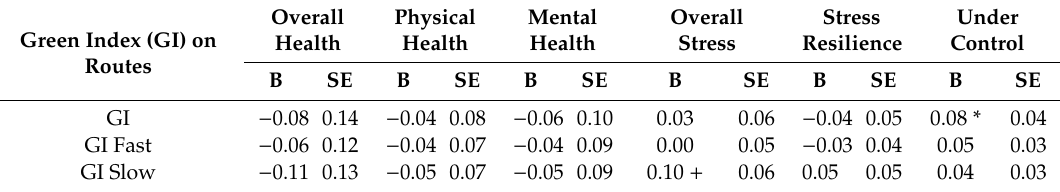
Table 6. Relationship between Weighted Green Index along Daily Routes and Health Outcomes. Overall Physical Mental Overall Stress Under Green Index (GI) on Health Health Health Stress Resilience Control Routes B SE B SE B SE B SE B SE B SE GI − 0.08 0.14 − 0.04 0.08 − 0.06 0.10 0.03 0.06 − 0.04 0.05 0.08 * 0.04 GI Fast − 0.06 0.12 − 0.04 0.07 − 0.04 0.09 0.00 0.05 − 0.03 0.04 0.05 0.03 GI Slow − 0.11 0.13 − 0.05 0.07 − 0.05 0.09 0.10 + 0.06 0.05 0.05 0.04 0.03 + , p < 0.1; *, p <